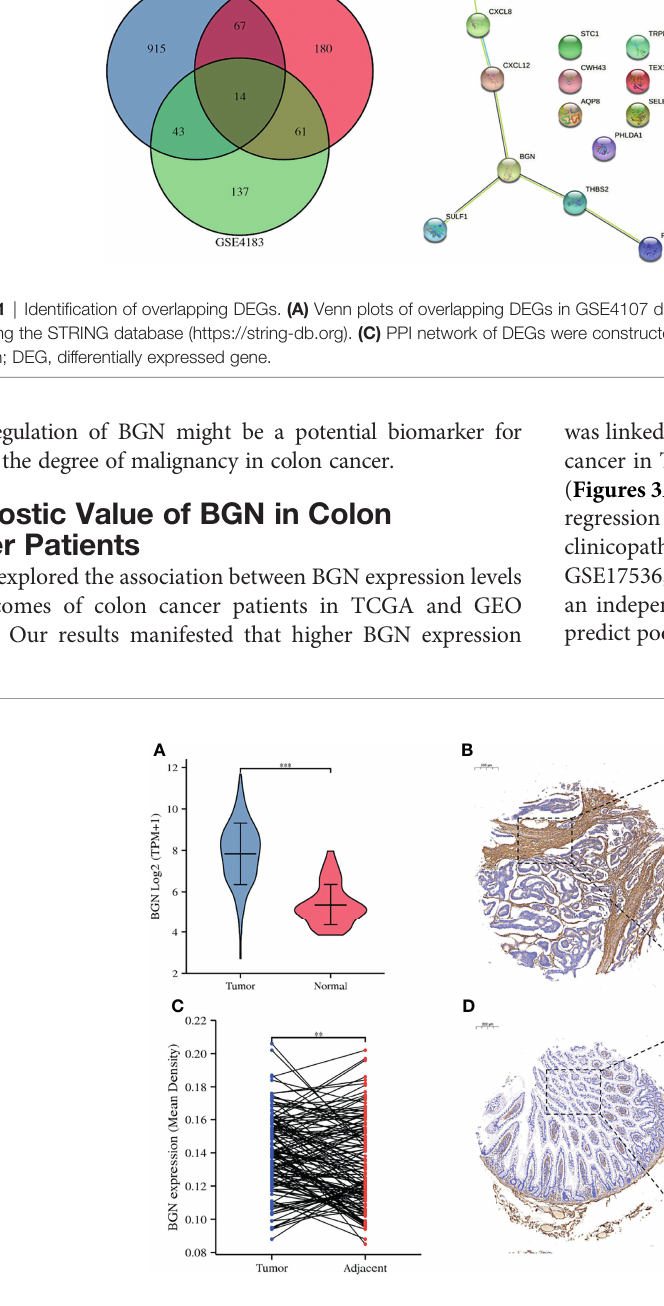
FIGURE 2 | The expression levels of BGN were signi fi cantly upregulated in patients with colon cancer. (A) The mRNA expression of BGN in the normal and tumor samples in TCGA. Data are represented as the mean ± SD. The Y-axis represents log2 (TPM+1) transformed RNA seq expression data. Wilcoxon rank sum test served as the statistical signi fi cance test. (B, D) Immunohistochemistry staining of example colon cancer patients with positive BGN staining in tumor tissues and the negative BGN staining in adjacent tissues. (C) Paired differentiation analysis for mean density of BGNs detected by immunohistochemistry staining sin tumor and paired adjacent tissues deriving from tumor microarray. The Wilcoxon signed rank test was used for comparison. Signi fi cant differences referred ass: **p < 0.01, ***p <